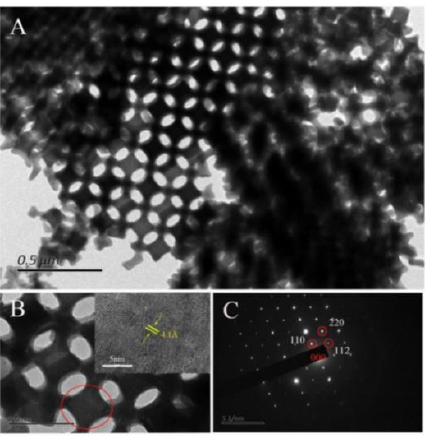
Figure 4. TEM images of ( A ) 2/AS-IO-CsPbBr 3 , ( B ) an enlargement of (A) and high resolution-TEM (HR-TEM) (inset) and ( C ) the selected area electron diffraction (SEAD) images of the circle area in (B).